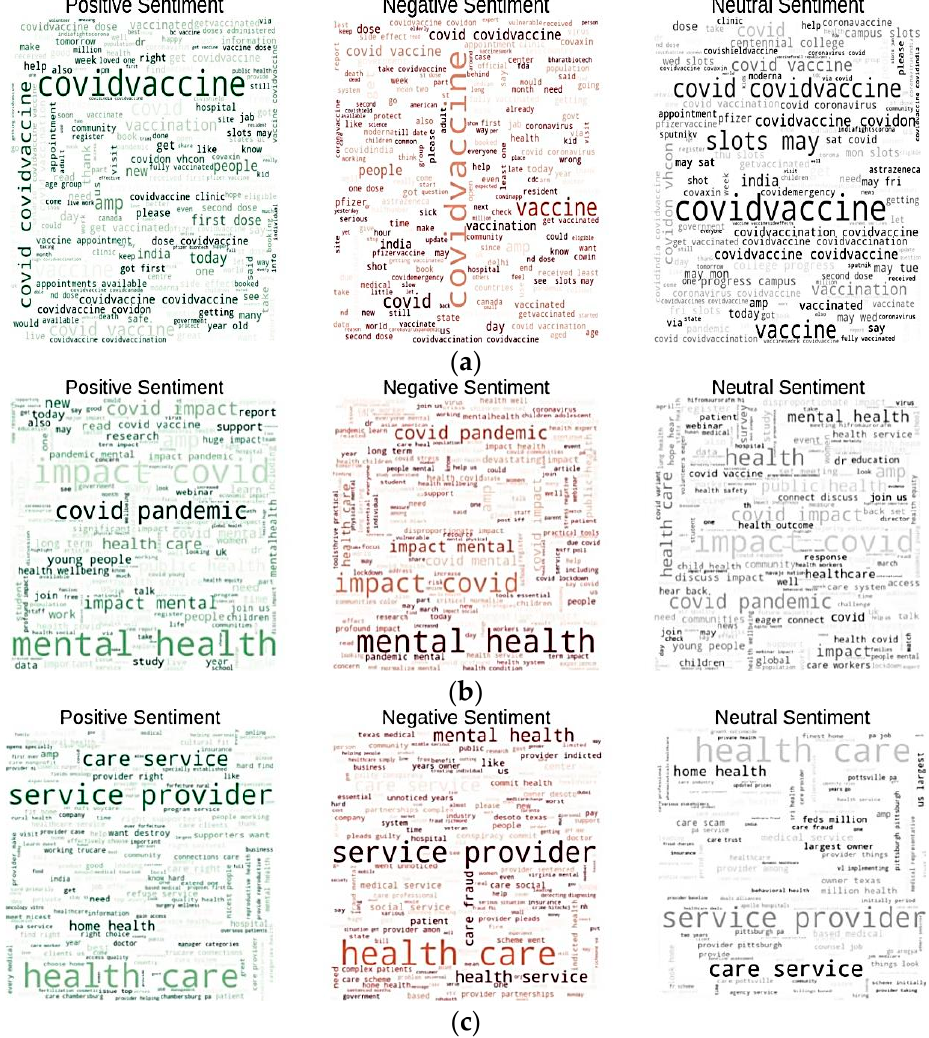
Figure 3. Word clouds for: ( a ) COVID-19 vaccine; ( b ) COVID-19 health factors; ( c ) health service providers.